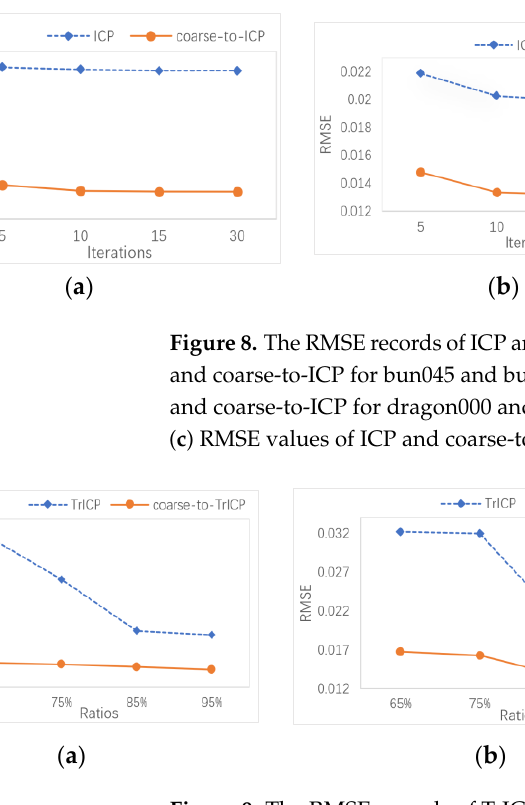
Figure 9. The RMSE records of TrICP and coarse-to-TrICP with different ratios. ( a ) RMSE values of TrICP and coarse-to-TrICP for bun045 and bun090 with 0.65, 0.75, 0.85, 0.95 ratio settings. ( b ) RMSE values of TrICP and coarse-to-TrICP for dragon000 and magnified twice dragon048 with 0.65, 0.75, 0.85, 0.95 ratio settings. ( c ) RMSE values of TrICP and coarse-to-TrICP for face000 and face045 with 0.65, 0.75, 0.85, 0.95 ratio